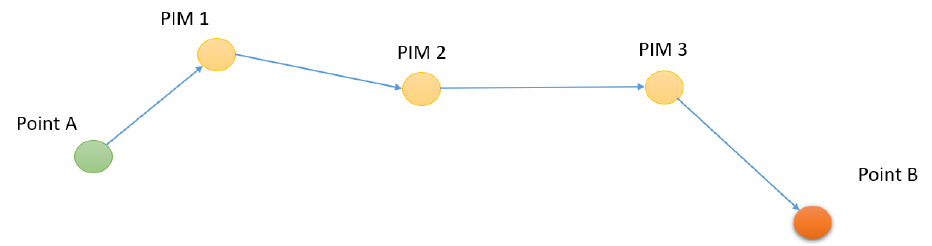
Figure 8. Movement strategy from point A to point B through Points of Interest for Mobility.